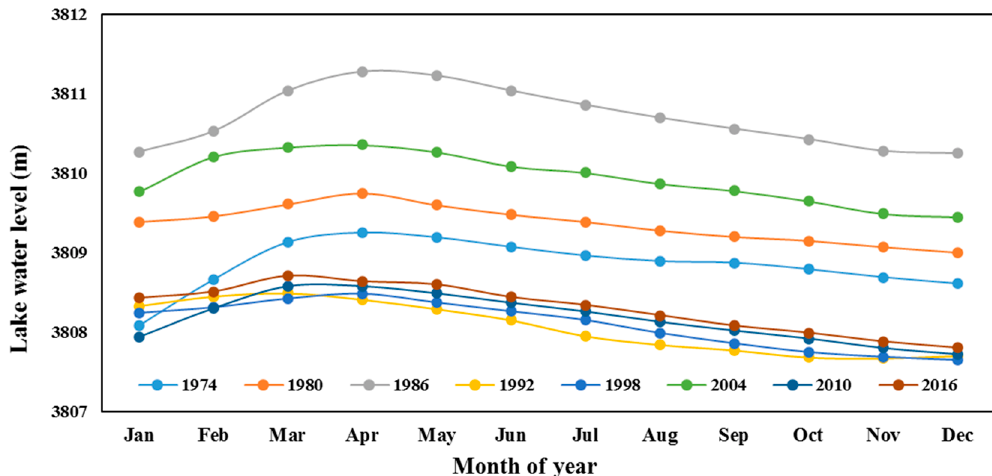
Figure 3. Monthly time series of water level for some years of the study period.